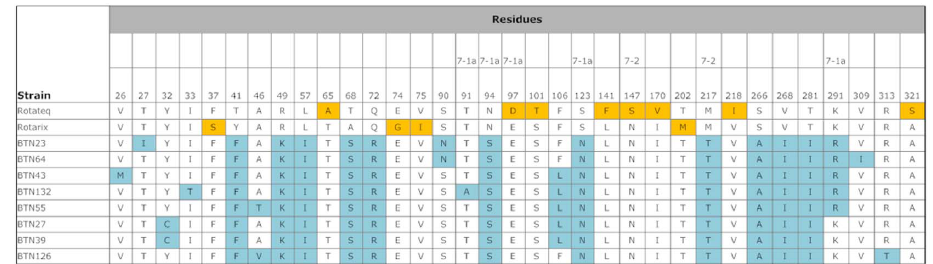
Figure 3. Comparison of the antigenic residues of VP7 present in genotype G1 strains of RotaTeq and Rotarix, and the strains circulating in Bhutan. The respective antigenic epitopes are shown above the residue numbers. The amino acid residues in the Bhutanese strains that differed from those in the vaccine strains are highlighted in blue. The amino acid residues highlighted in yellow indicate that the residue is different from the other vaccine strain and Bhutanese strains.